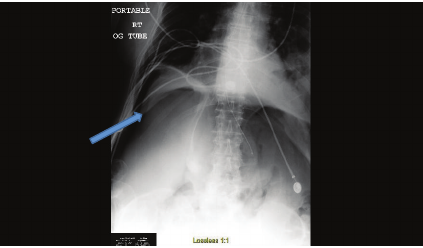
Figure 1: Chest/abdomen X-ray showing right pneumothorax and also air under diaphragm suggesting perforated viscus.